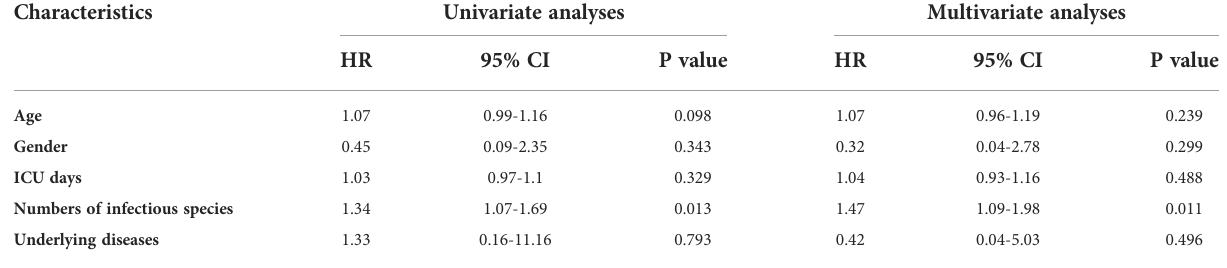
TABLE 4 Univariate analysis and multivariate analysis of overall survival in nocardiosis patients.